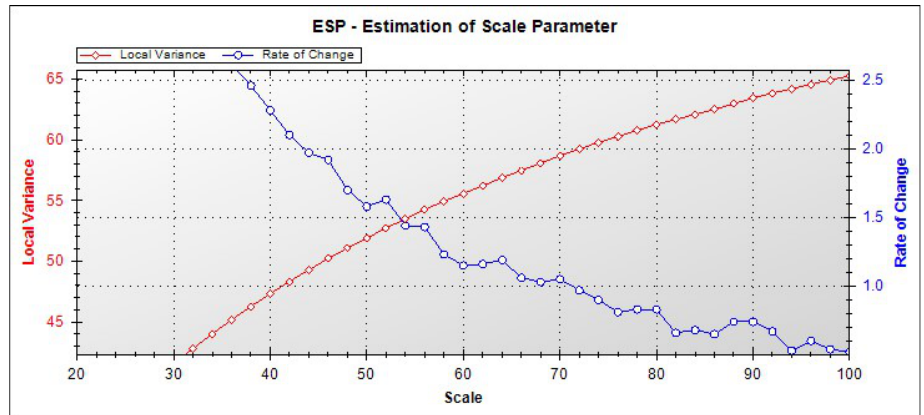
Figure 6. Curve of the local variable and rate of change graph exported from the estimation of scale parameter; the local maximum is the potential optimal scale for the scene, indicating that 52, 64, 80, 88, and 96 are potential scales for segmentation.